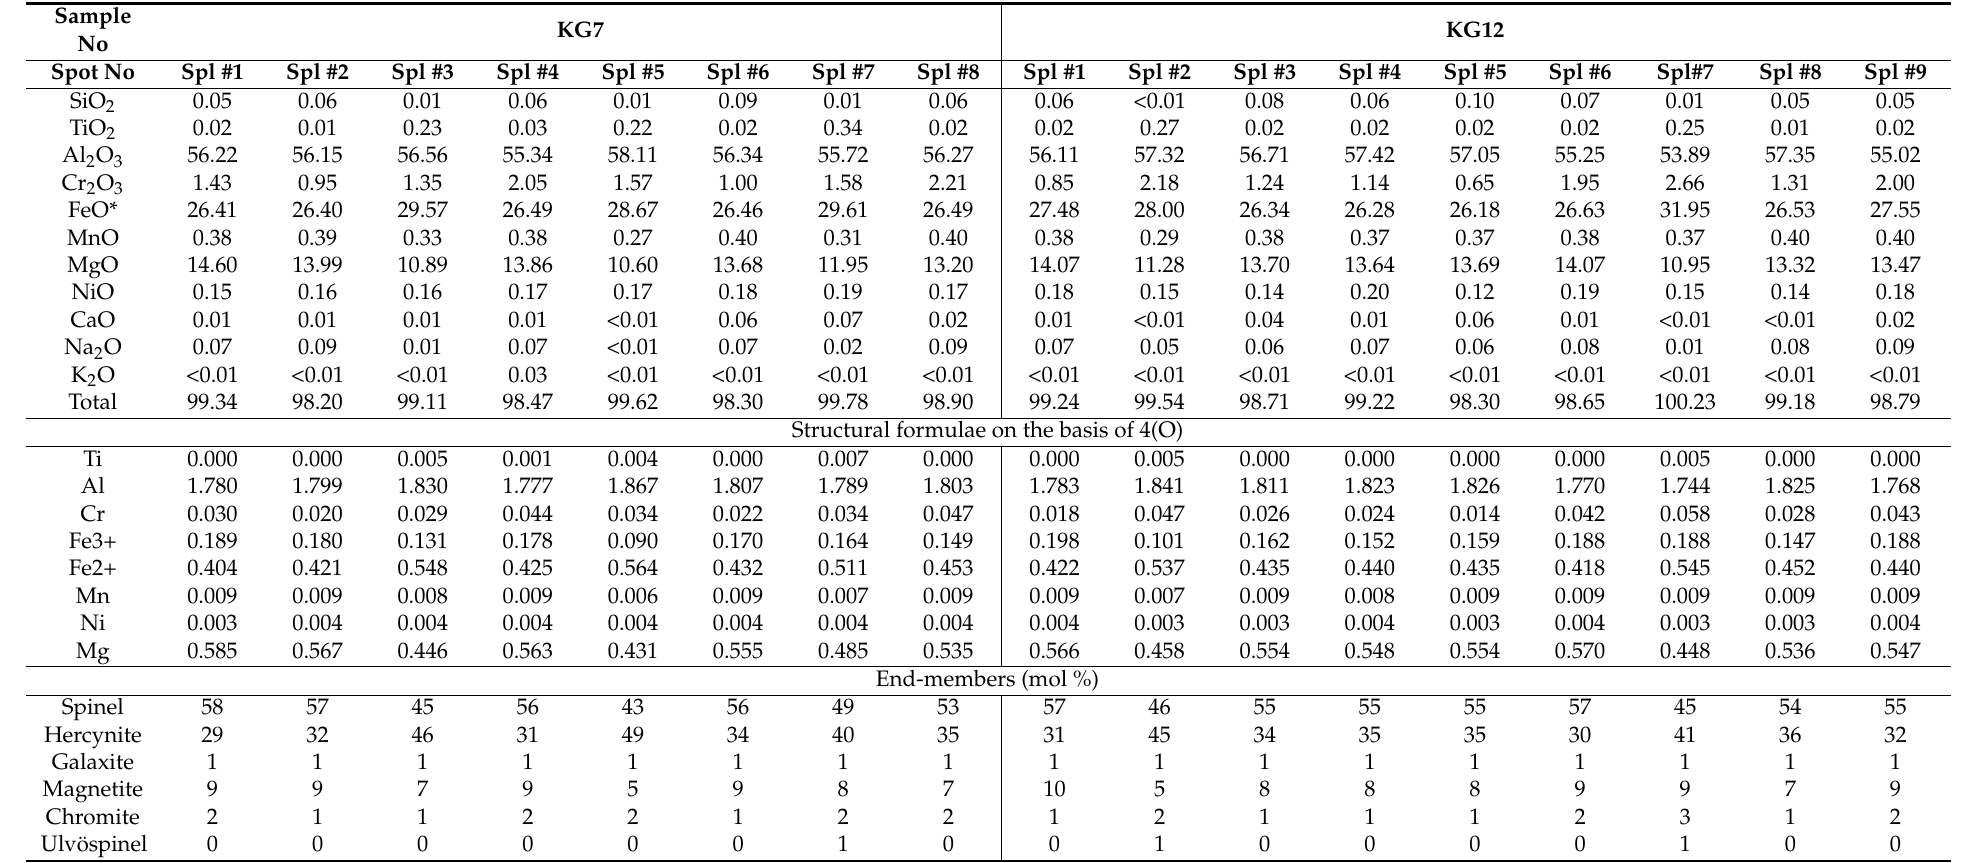
Table 5. Microprobe analyses of green spinel in the olivine gabbro of the Khamal mafic